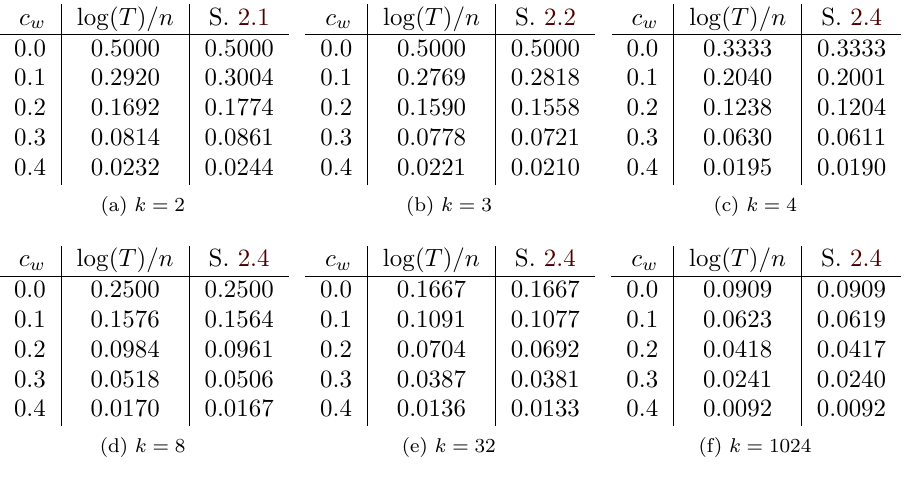
Figure 14: Running time exponents log( T )